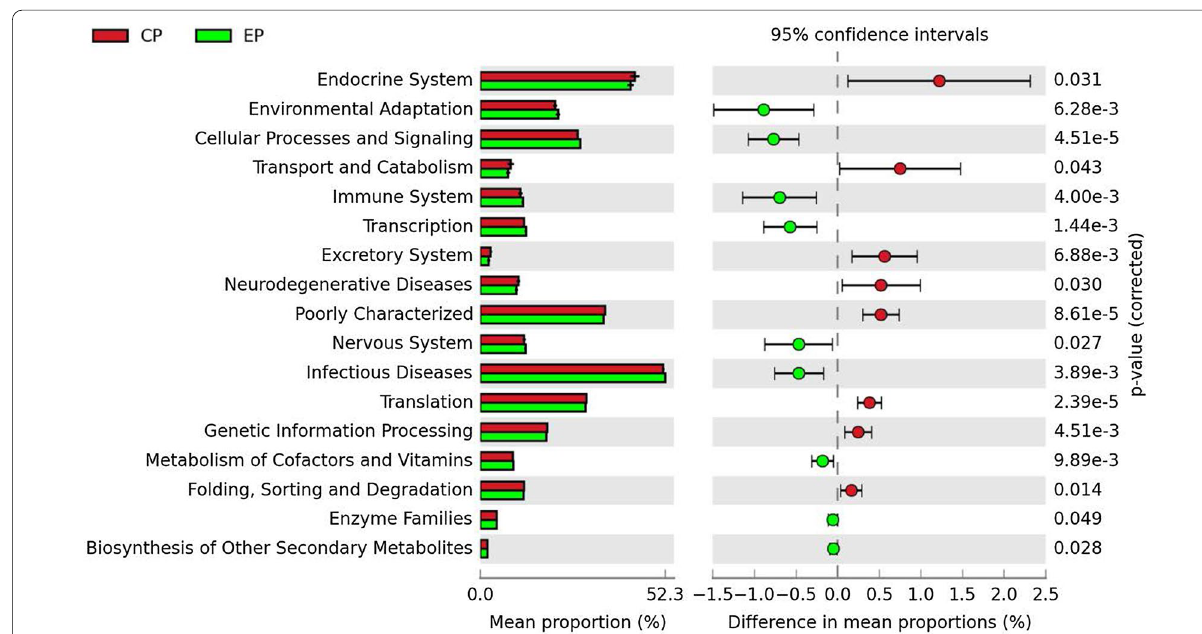
Fig. 4 Predicted functions of the microbial flora in the CP and EP pigs. The third‑level KEGG pathways are shown in the post hoc plot. The significance of gene distribution between groups was determined by ANOVA, with a P value < 0.05